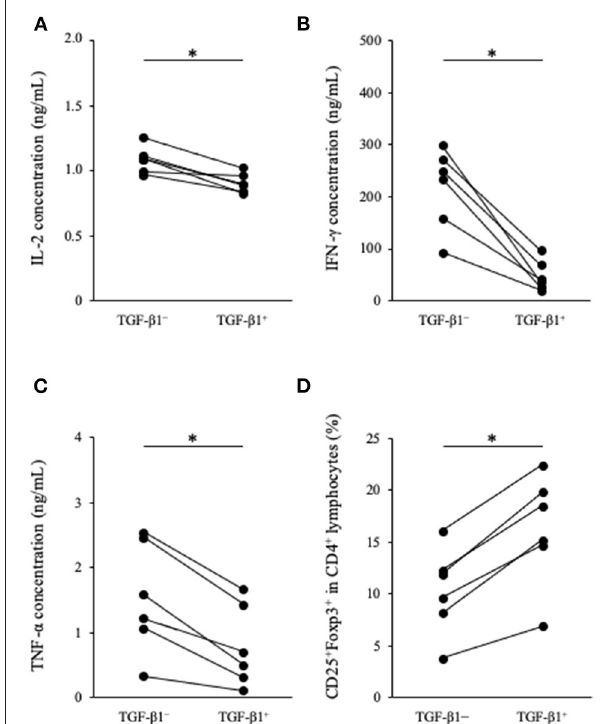
FIGURE 2 | Effect of TGF- β 1 on Th1 cytokine production and Tregs differentiation in PBMC cultures. (A) IL-2, (B) IFN- γ , and (C) TNF- α concentrations in cell culture supernatant were measured by ELISA. (D) The percentage of CD25 + Foxp3 + cells among CD4 + lymphocytes was